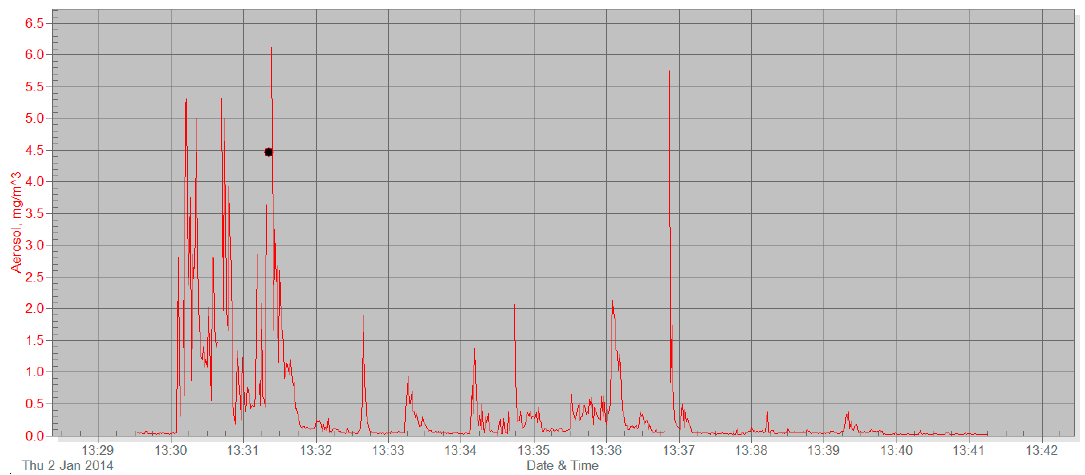
Figure 2. Real-time PM monitoring with Sidepak—two smokers outdoors.